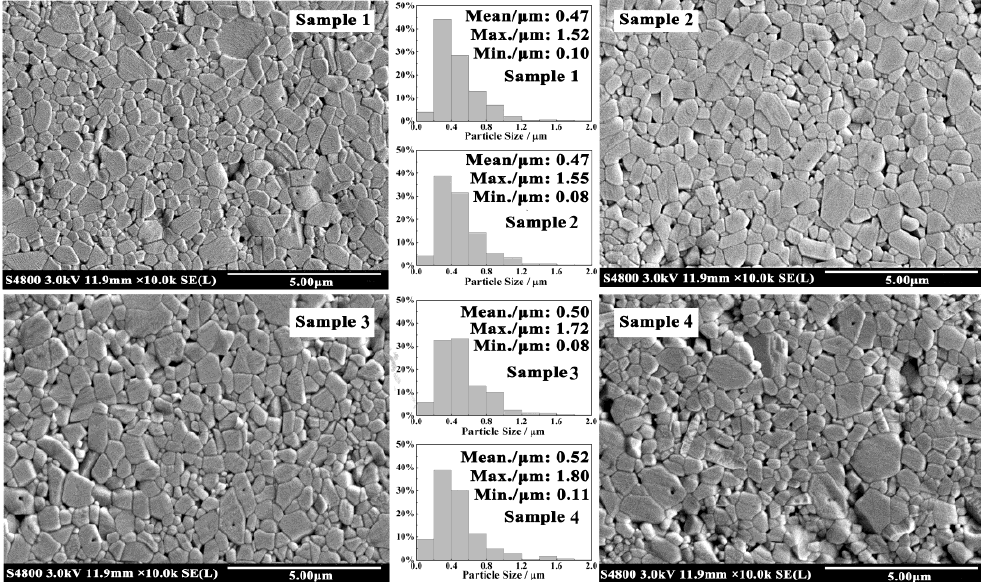
Figure 4. Field emission scanning electron microscope (FESEM) photographs of samples. The wear resistance of Sample 2 (0.01 wt% Gd 2 O 3 ) is the best; the wear resistance of Samples 3 and 4 are worse than that of Sample 1 without Gd 2 O 3 .